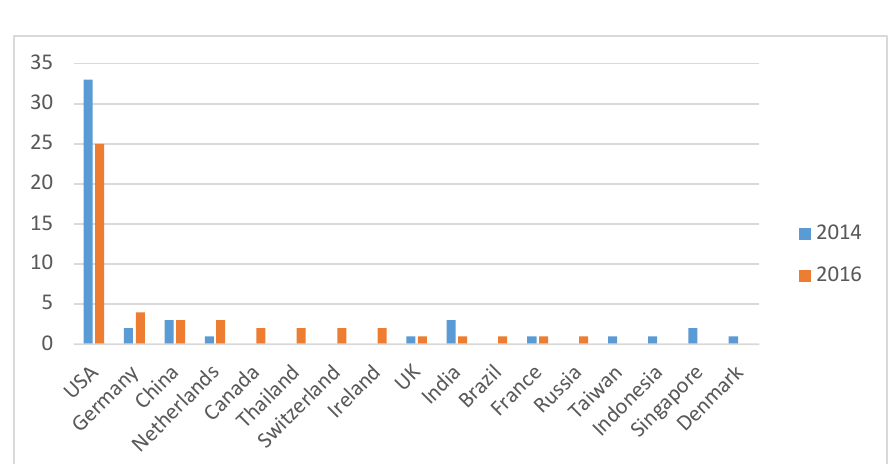
Fig. 1. List of countries with open innovation job posting in February 2014 and